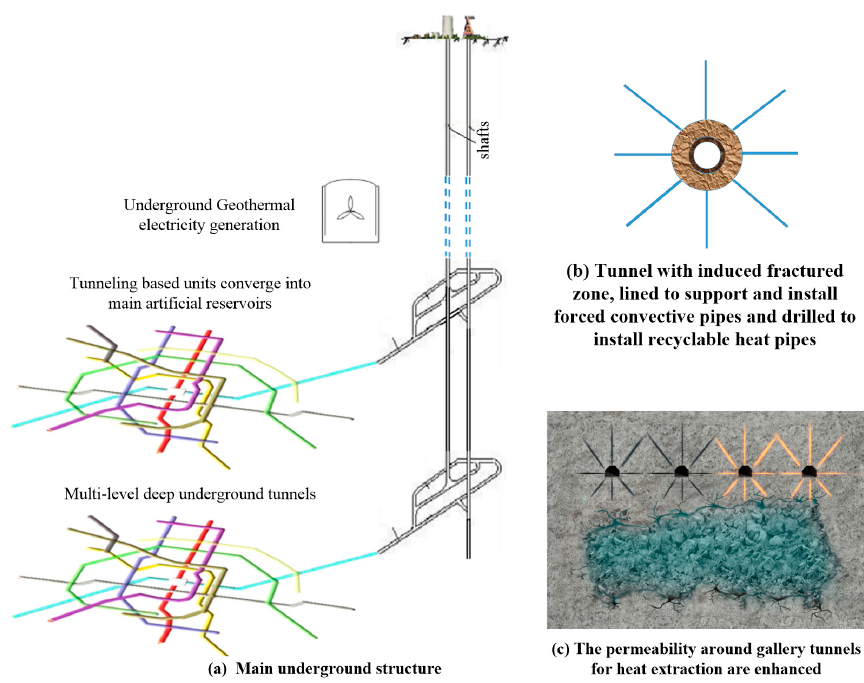
Figure 1. Schematic illustration of the EGS-E conceptual model.